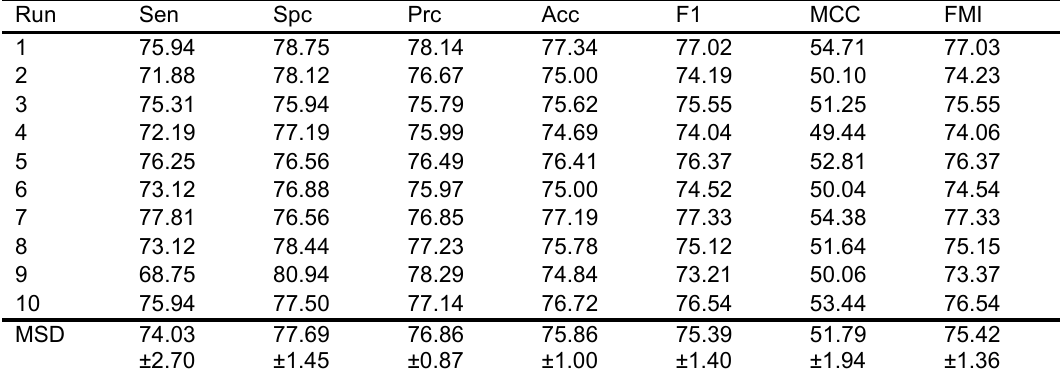
Table 5. Results of